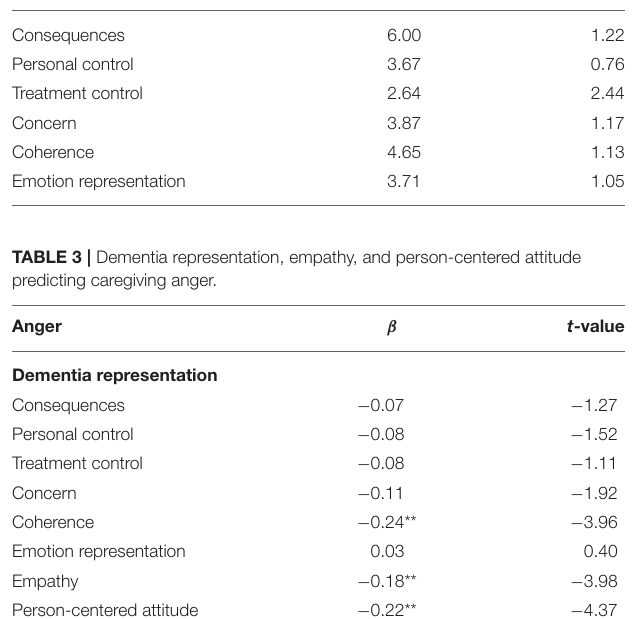
TABLE 2 | Mean scores and deviations of every dimensions of DR.